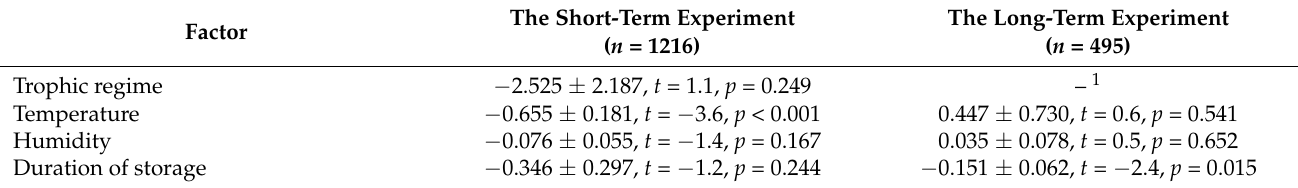
Table 3. Influence of the trophic regime, temperature, humidity, and duration of storage on the percentage of hatched eggs in Cheilomenes propinqua (the results of the GLM analysis: the regression coefficient ± SE, t -ratio, and significance of influence).